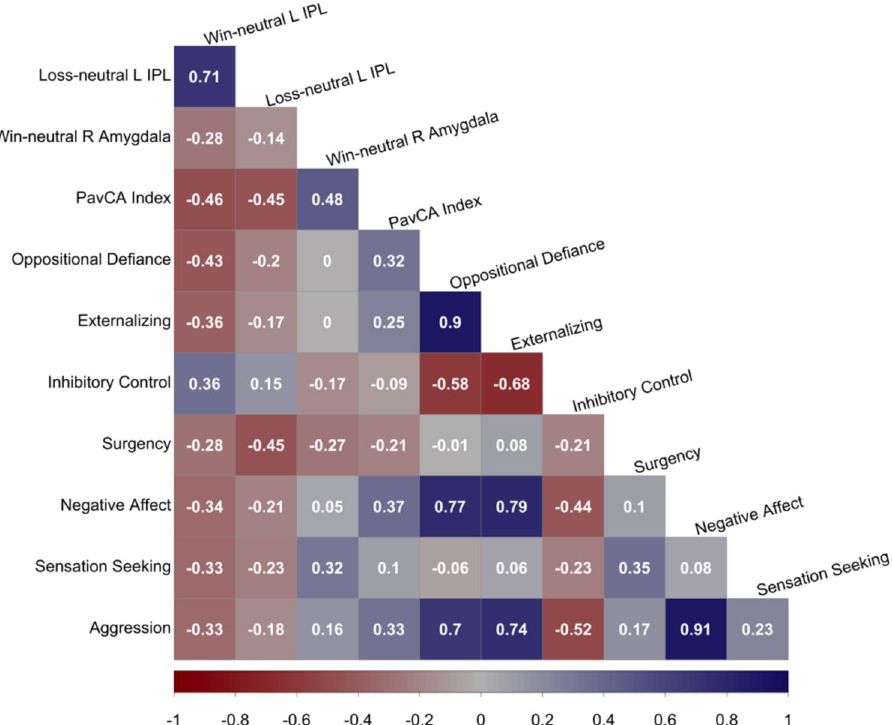
Figure 4. Pearson’s r correlations between brain activations and behaviors. L = left; R = right; IPL = inferior parietal lobe; PavCA Index = Pavlovian conditioned approach index. Strength of the correlation ( r value) is reported in the corresponding square with dark red indicating stronger negative relationships and dark blue representing stronger positive relationships. Correlations represent relationships between brain activations during the anticipation phase of the monetary incentive delay (MID) task. Blood oxygen level dependent (BOLD) activations for contrasts of percent signal change between neutral and salient conditions are used. Oppositional defiance = DSM-oriented subscale from the Child Behavior Checklist (parent report). Scores were log transformed due to non-normality. Externalizing problems = composite Child Behavior Checklist subscale (parent report); Inhibitory control = subscale from the Early Adolescent Temperament Questionnaire (parent report). Surgency = subscale from the Early Adolescent Temperament Questionnaire (parent report); Negative Affect = composite subscale including depressive mood, aggressive behaviors, and frustration on the Early Adolescent Temperament Questionnaire (parent report); Aggression = subscale from the Early Adolescent Temperament Questionnaire (parent report); Sensation seeking = subscale of the Urgency, Premeditation, Perseverance, Sensation Seeking, Positive Urgency scale (youth self-report). Image created in the R System for Statistical Computing 45 (R Core Team. R: a language and environment for statistical computing, Vienna, Austria, 2020, https:// www.R- proje ct. org/) using the package ‘corrplot’ 46 (Wei T, Simko V (2021). R package ’corrplot’: Visualization of a Correlation Matrix. (Version 0.92), https:// github. com/ taiyun/ corrp